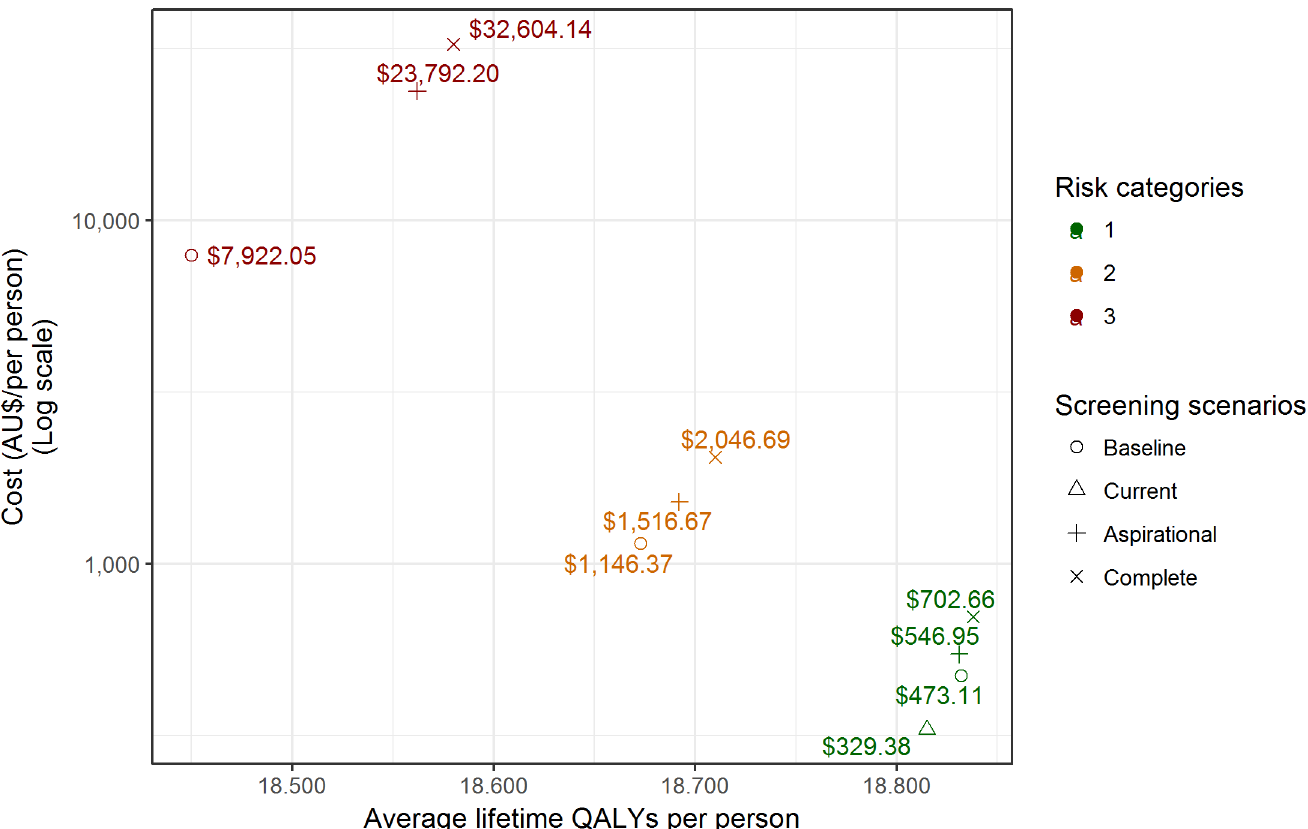
Fig 4. Cost and QALYs associated with different screening scenarios. QALY, quality-adjusted life year.